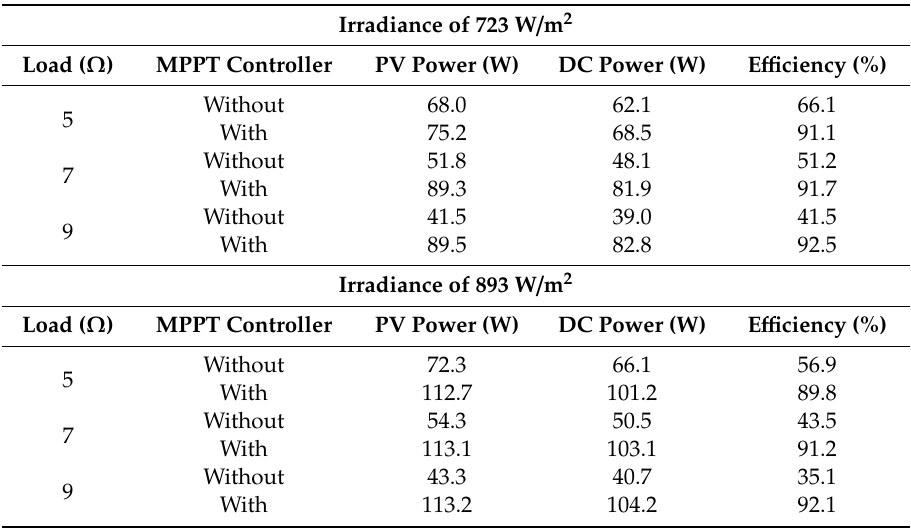
Table 8. Experimental results for verifying the MPPT